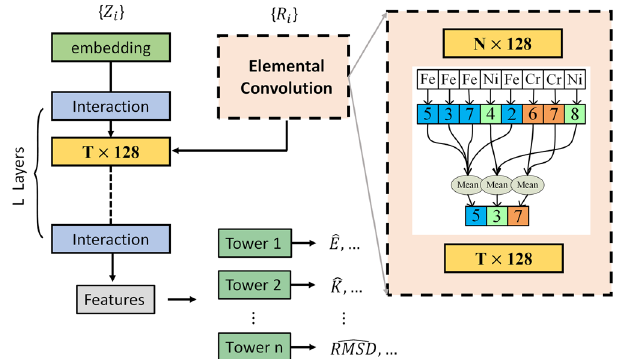
Fig. 1 The architecture for the ECNet model. The embedding layer is used to encode initial inputs from the atomic numbers. In the interaction block, a series of neural networks is used to transform the crystal structures into atomic attributes. The elemental convolution operation takes average values of atom-wise features according to the atomic element